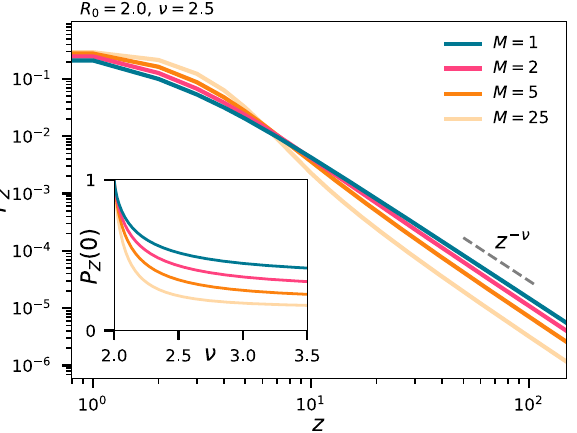
Figure 2. Offspring statistics. The distribution of Z , the number of individuals an infected individual will infect. Inset shows the probability that an individual will infect precisely zero. In all plots we take a